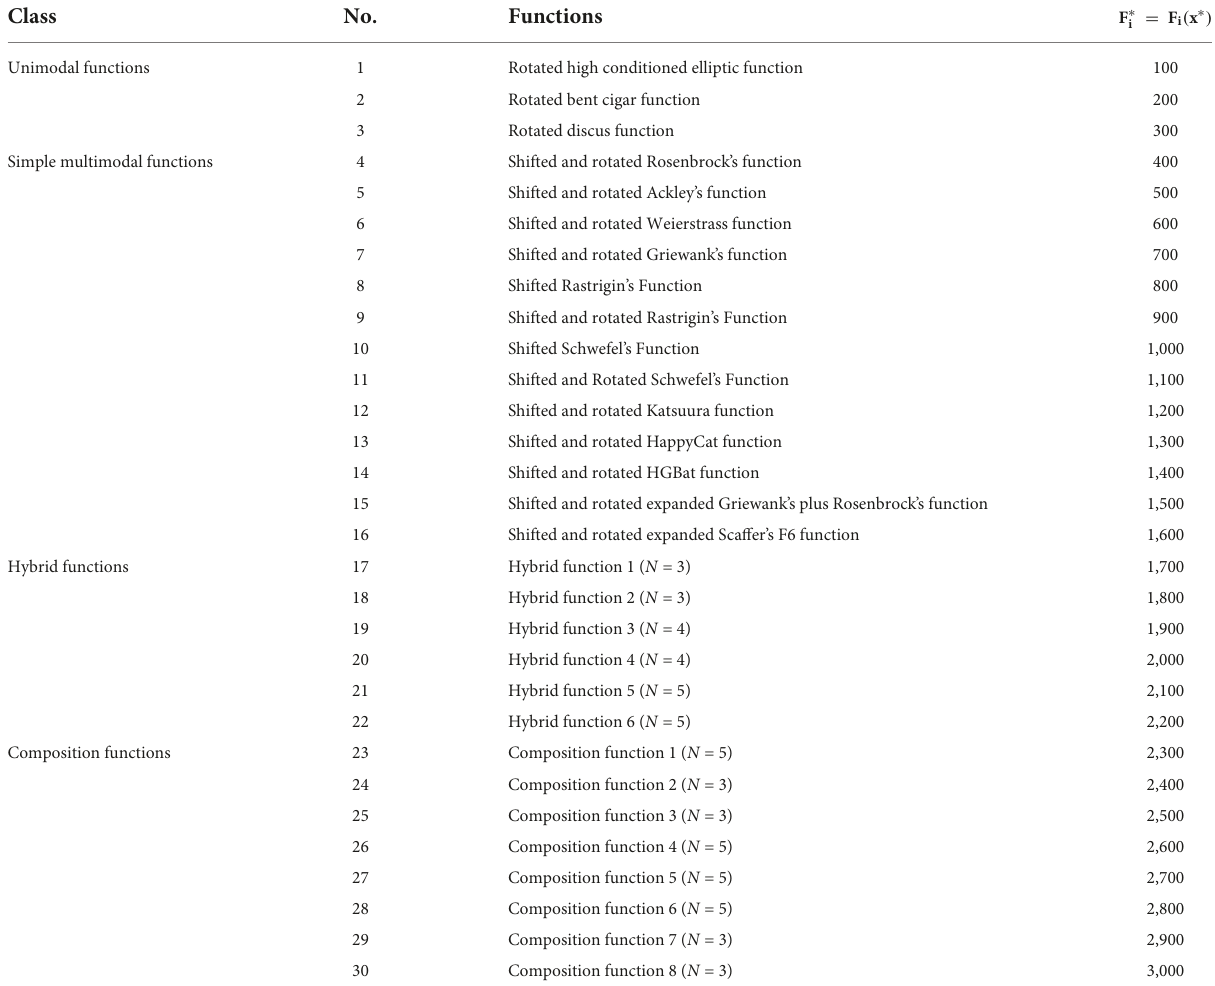
TABLE 1 Description of the 30 benchmark